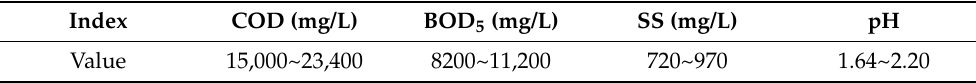
Table 2. Test water quality